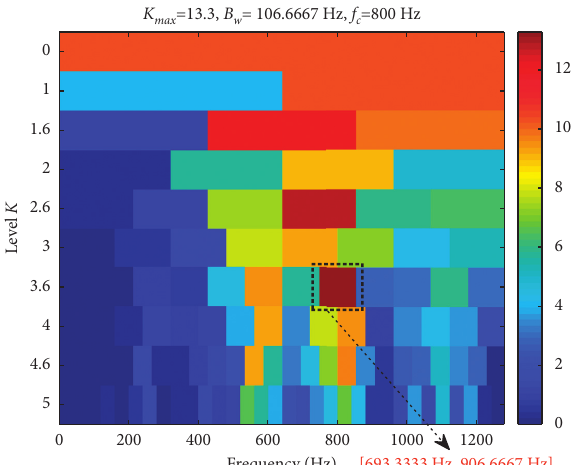
Figure 7: FSK map of the inner fault of the SKF 6205-2RS deep groove ball bearing.